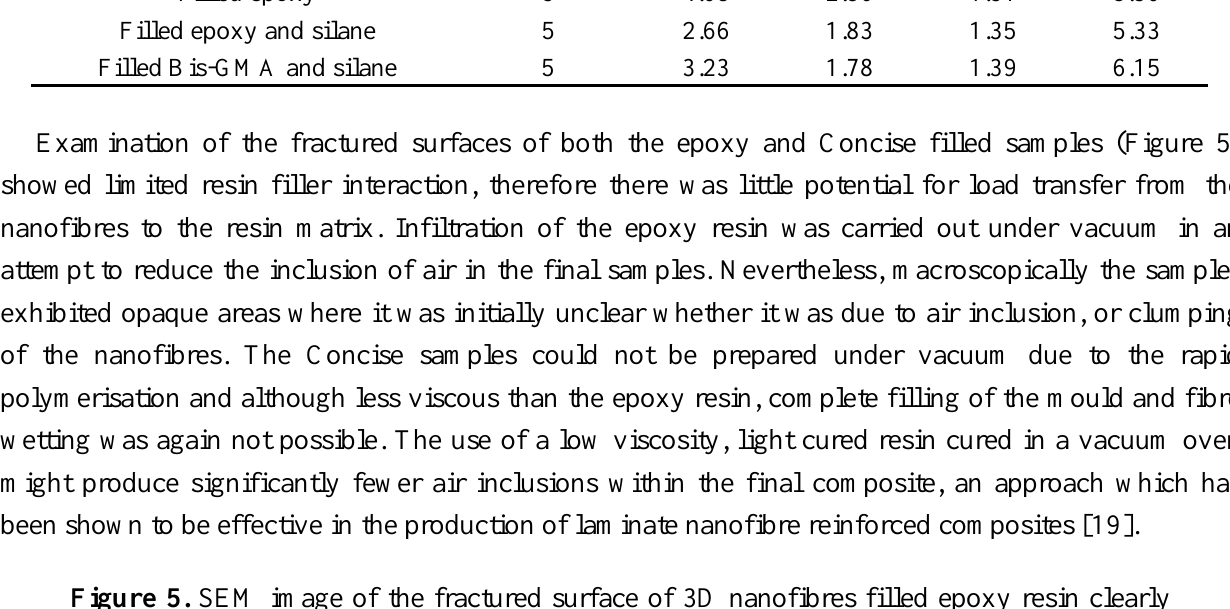
Figure 5. SEM image of the fractured surface of 3D nanofibres filled epoxy resin clearly showing how some fibres have not been infiltrated by the